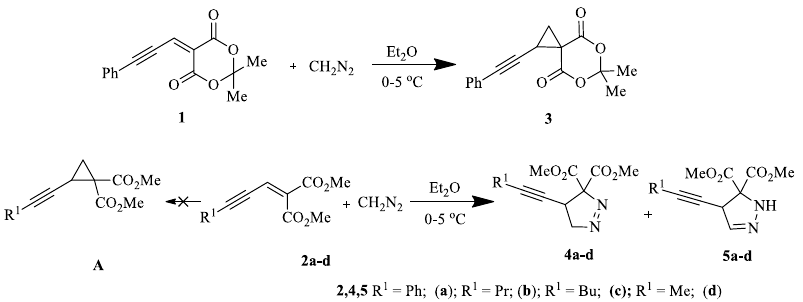
Figure 40. Reaction of enynes with diazomethane solution.